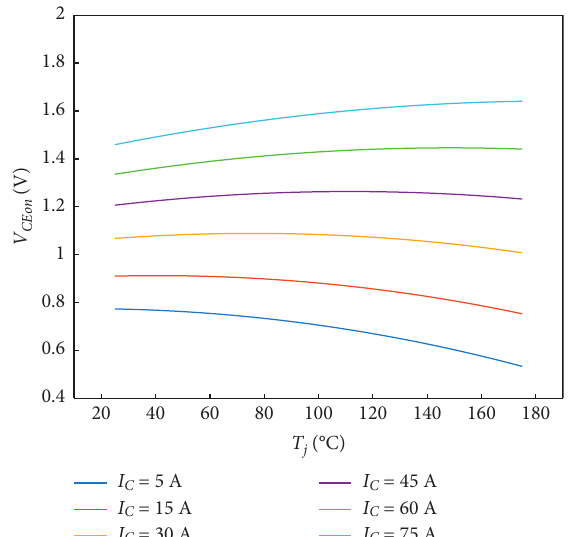
Figure 7: The relationship between junction temperature and on-state voltage with different collector